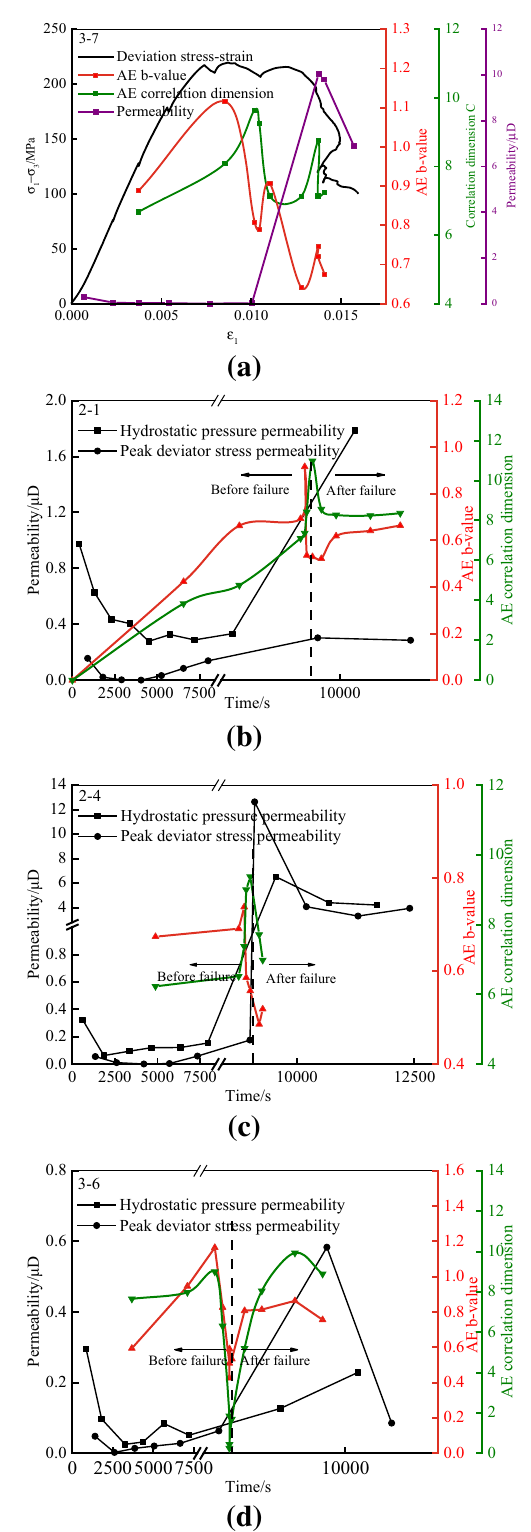
Fig. 8 The evolution of AE fractal characteristics and the perme- ability: a specimen 3–7, b specimen 2–1, c specimen 2–4, d